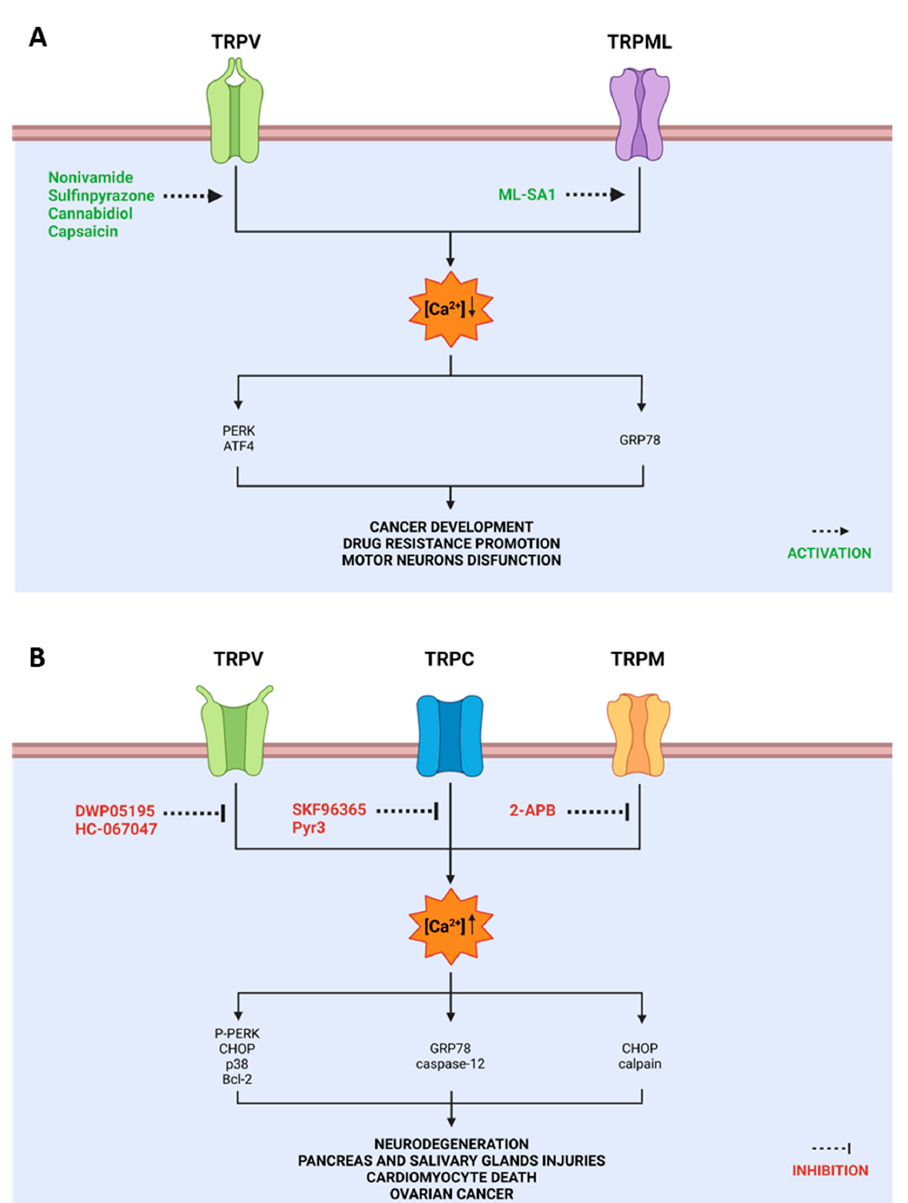
Figure 3. Activation ( A ) and inhibition ( B ) of TRP channels involved in ER stress modulation. The opening or blocking of these channels affects the flow of intracellular calcium by modulating vari- ous biological functions including drug resistance, cancer survival, neurodegeneration and tissue injuries. Color code: antagonists and inhibitors of TRP expression are indicated in red; agonists are reported in